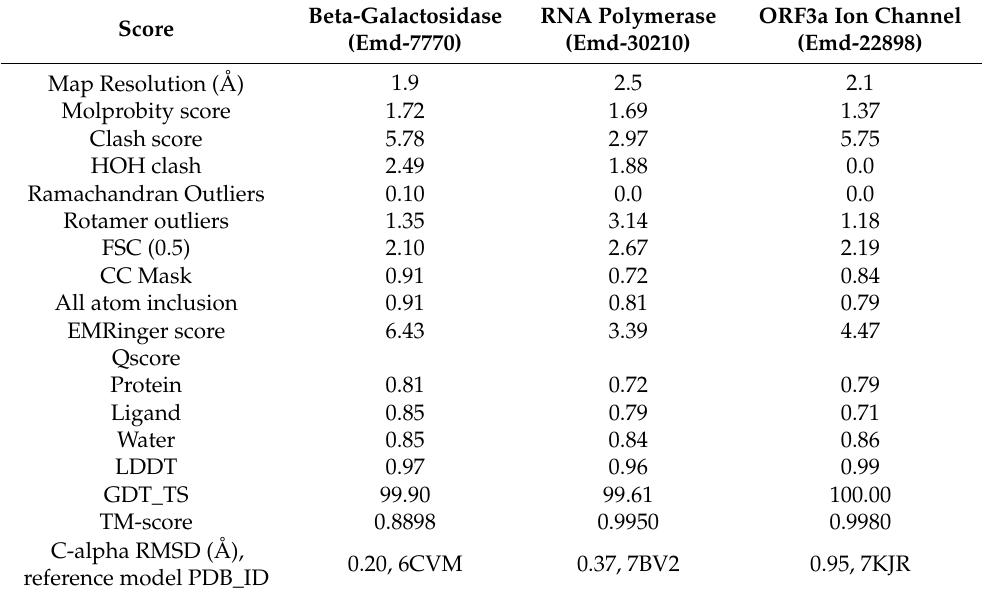
Table 3. Modeling Results. A table summarizing the results for the three datasets from the 2021 CryoEM Ligand Challenge is shown. All statistics were taken directly from the model compar- ison pipeline (https://model-compare.emdataresource.org/2021/cgi-bin/index.cgi, accessed on 1 January 2022) or generated with Phenix. All scores are generated using the final, refined model with the exception of the TM-score, which was calculated from the probabilistic model. RMSDs are calculated using only C-alpha